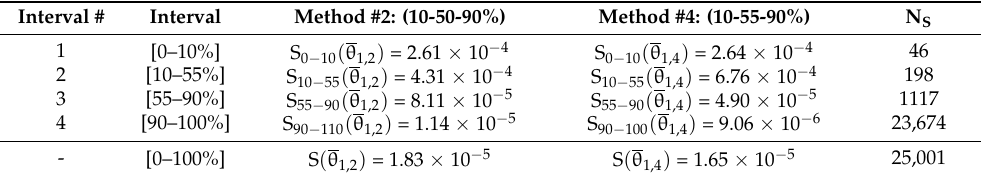
Table 14. Comparison between methods #2 and #4 in terms of time-domain model performance indices for different intervals of the process reaction curve for both identified models. The time- domain performance index for the whole response is also included in this table. N S represents the number of points for each interval.